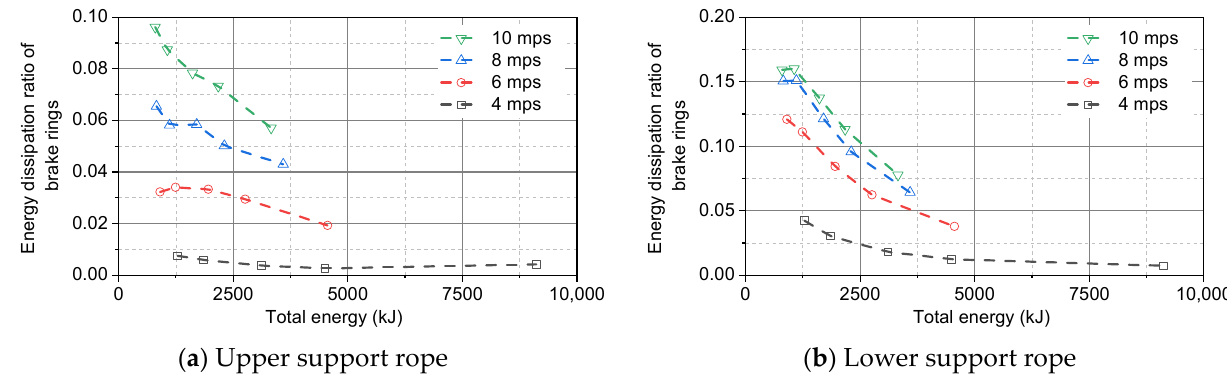
Figure 15. Energy dissipation ratio of brake rings.